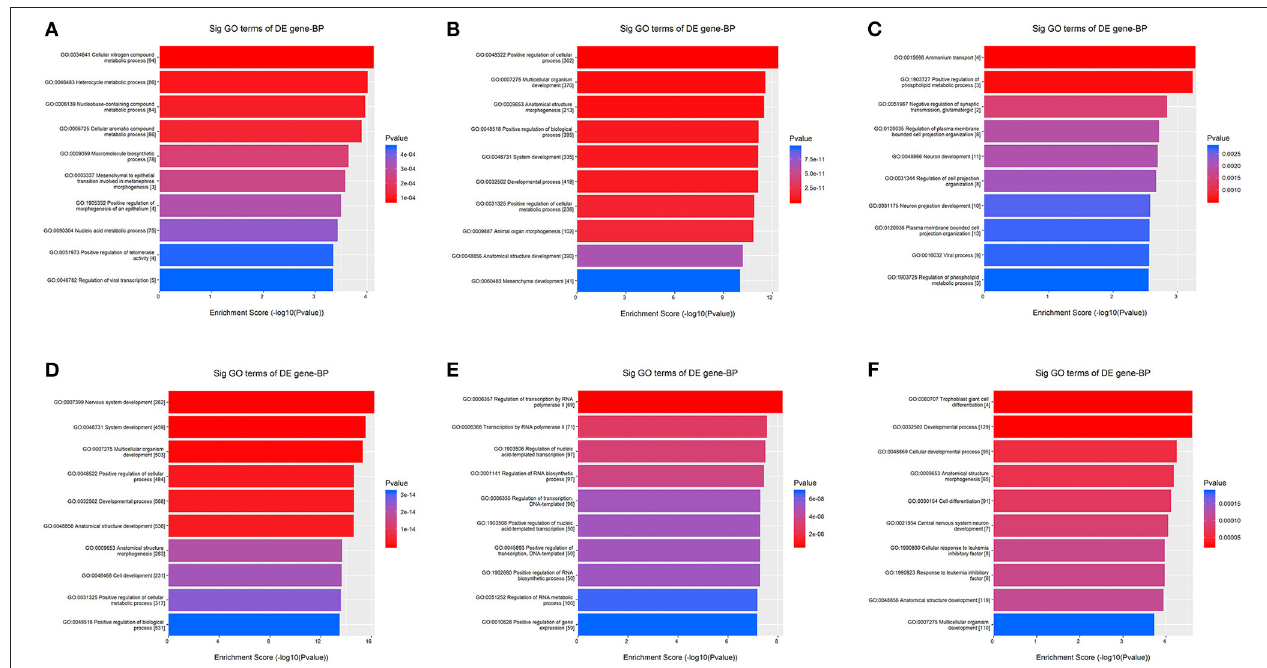
FIGURE 3 | GO analysis—Biological Processes. The bars plots show the top 10 enrichment score values of the significant enrichment terms. X-axis: GOID’s enrichment score value; it equals –log10( p -value); Y-axis: GO category. (A) Upregulated in known HPT vs. normotensive. (B) Downregulated in known HPT vs. normotensive. (C) Upregulated in screen-detected HPT vs. normotensive. (D) Downregulated in screen-detected HPT vs. normotensive. (E) Upregulated in known HPT vs. screen-detected HPT. (F) Downregulated in known HPT vs. screen-detected